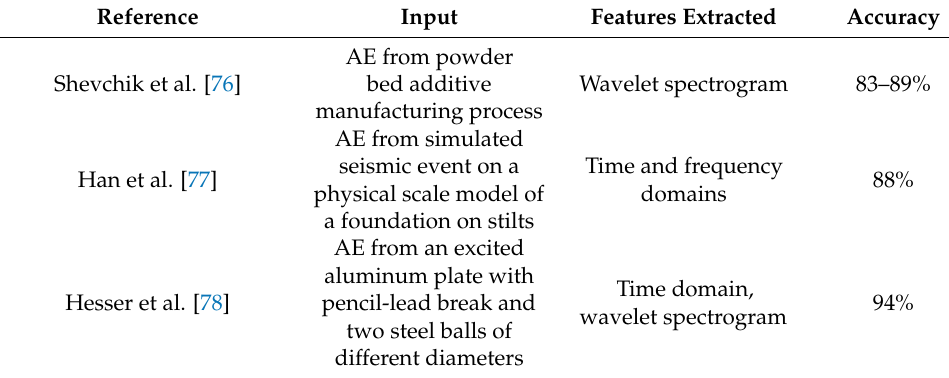
Table 3. CNN-based methods for AE